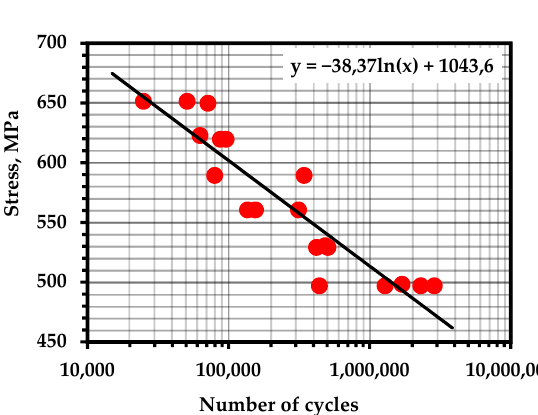
Figure A1. S–N Curve—Inconel 625 (Temperature—300 K; frequency—10 Hz; R = 0.1) [45].